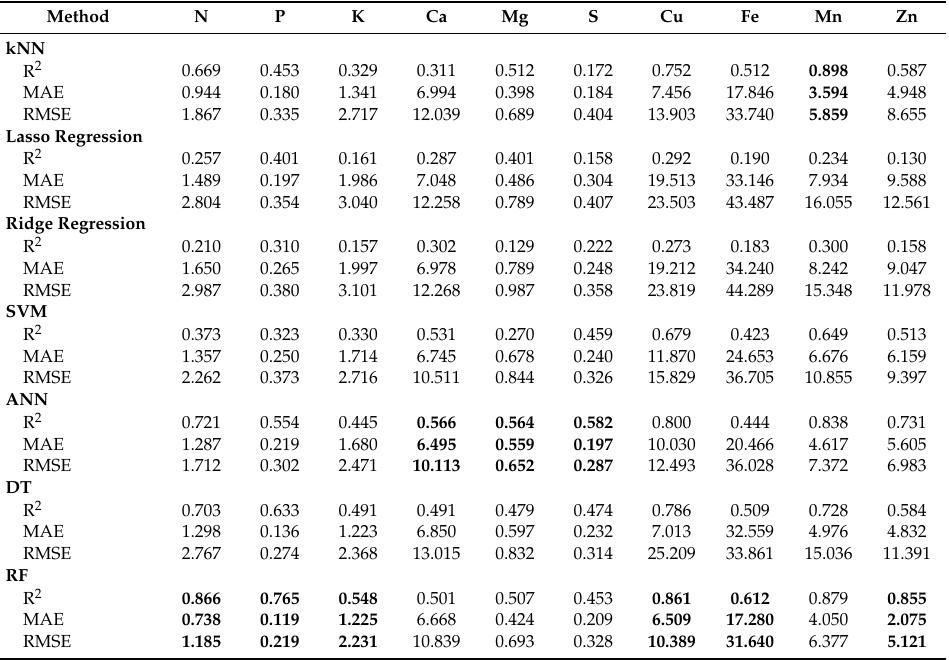
Table 5. The machine learning algorithms’ accuracy performance for first-derivative